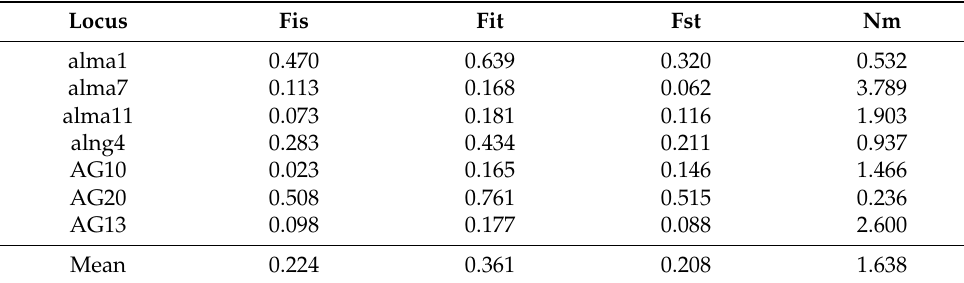
Ht = total expected heterozygosity; Ho = observed heterozygosity; He = expected heterozygosity; Fis = (Mean He − Mean Ho)/Mean He; Fit = (Ht − Mean Ho)/Ht; Fst = (Ht − Mean He)/Ht; Nm = [(1/Fst) − 1]/4. STRUCTURE analysis identified two core genetic groups (most likely number K = 2). The plot of STRUCTURE’s results (Figure 4) highlighted a clear genetic distinction between pure A. cordata populations (core ‘Group I’), and pure A. glutinosa populations (core “Group II”). The individuals of mixed populations of A. cordata/A. glutinosa showed a high level of admixture between the two core genetic groups, with varying level of kinship to the gene pools of the pure